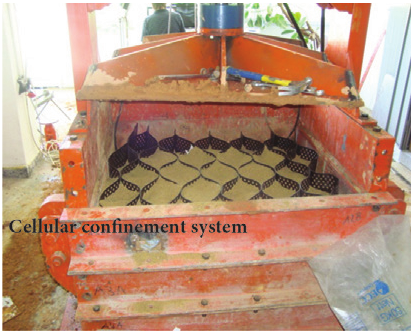
Figure 6. Confinement cells placed on the base soil were filled with sand